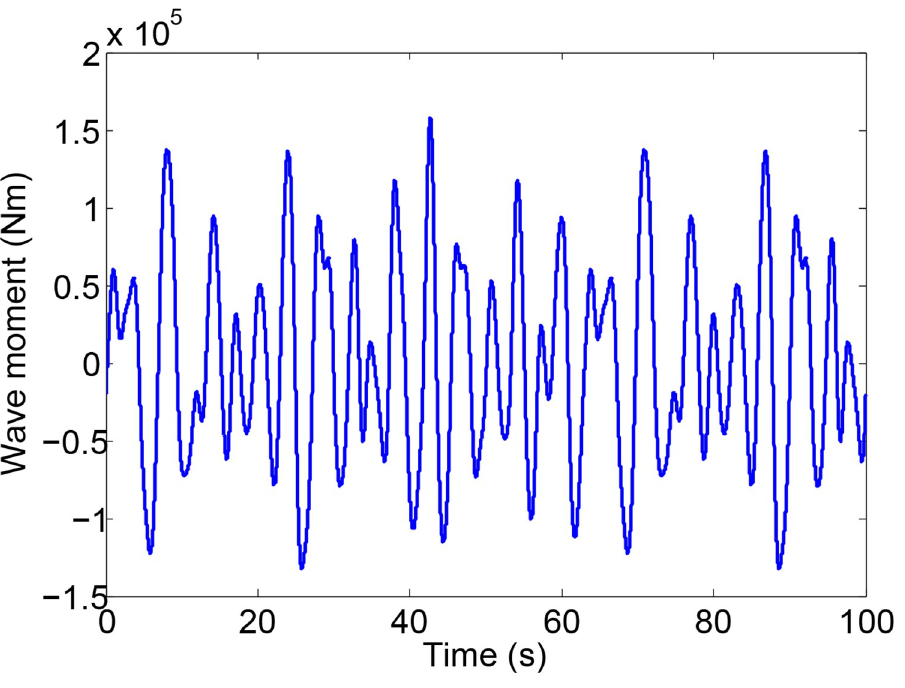
Fig 8. Wave disturbance